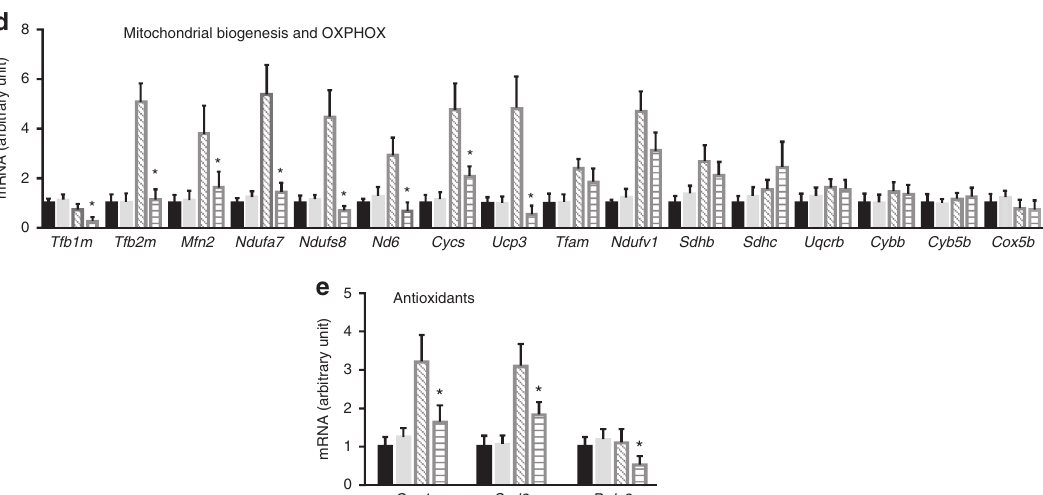
pro fi le using tandem mass spectrometer and observed a differential pro fi le of ceramide species in CKO hearts versus Flox hearts. 9 species were detected in the hearts. Among these species, the level of 6 species was elevated in chow-CKO compared with chow-Flox hearts, the level of 8 species was higher in HFD-CKO compared with HFD-Flox hearts, and the amount of CER[N(24)S (16)] and CER[N(24)S(17)] was augmented in HFD-CKO hearts compared with HFD-Flox and chow-CKO hearts (Fig. 4d). Next, we evaluated oxidative stress in HFD-CKO hearts.